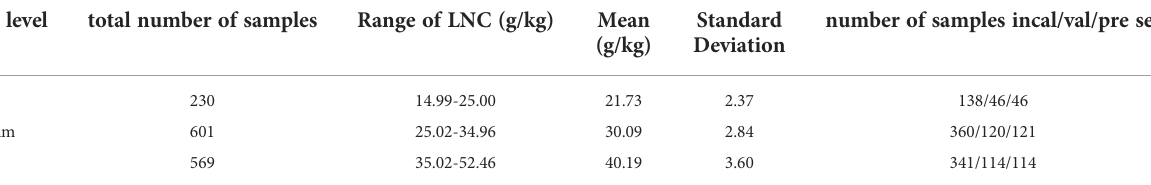
TABLE 1 Statistical information of composition of the cotton